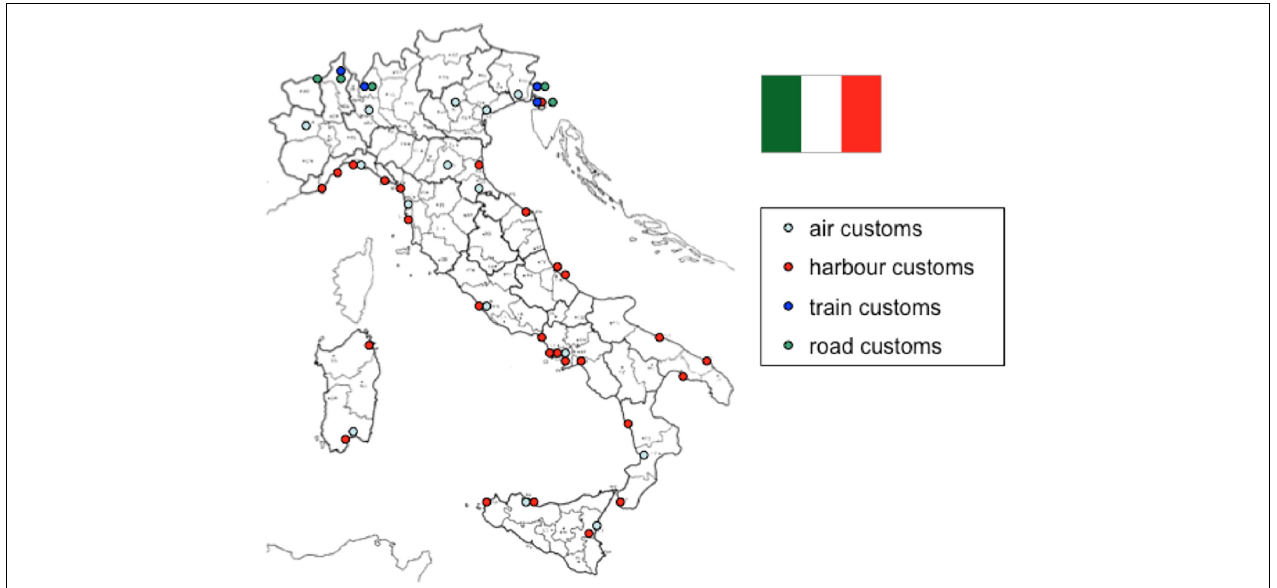
FIGURE 2 | Map of the customs locations in